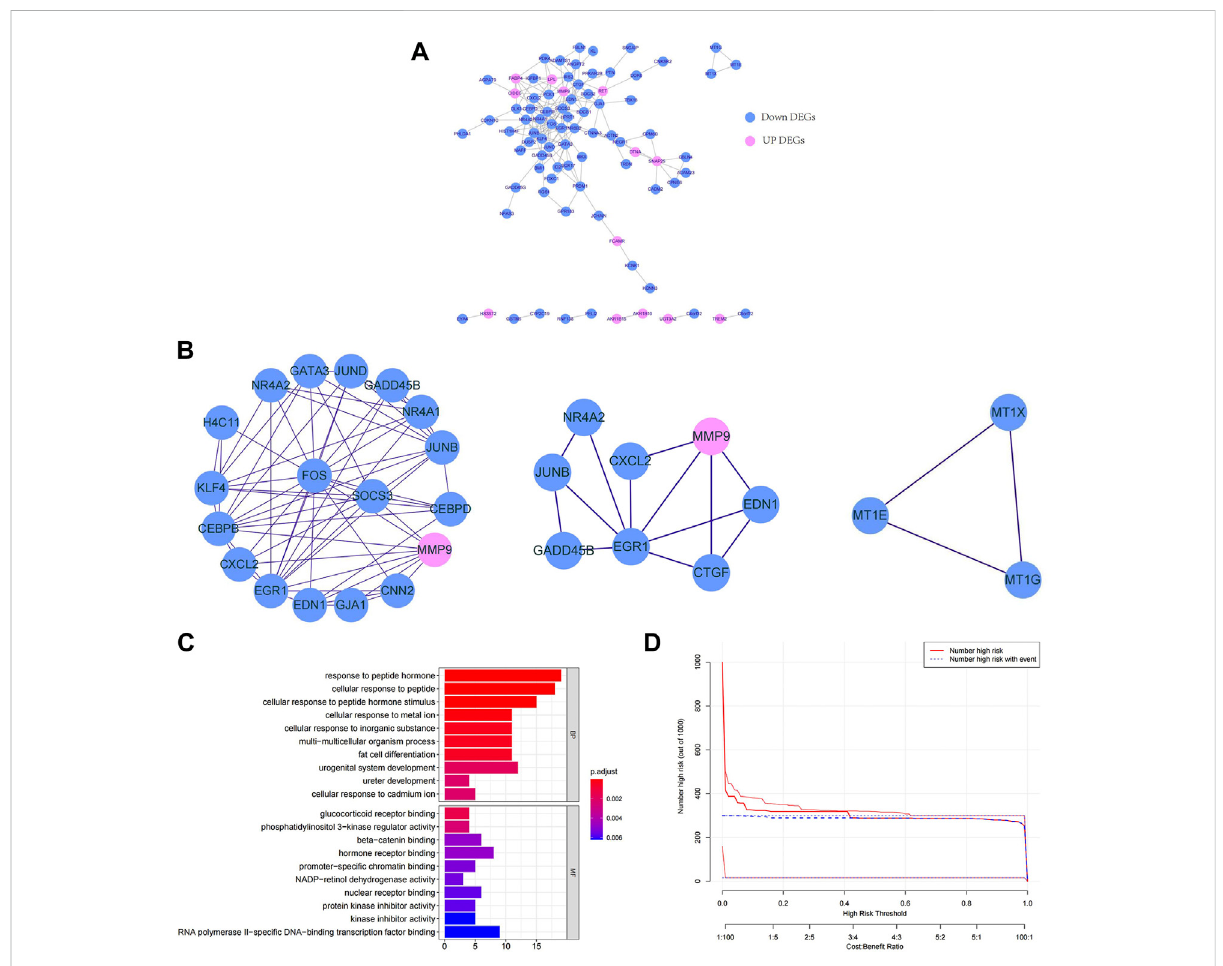
FIGURE 2 Functional enrichmentanalysis andinteractionofkeyDEGs. (A) PPInetwork ofkeyDEGs. (B) KeymodulesinthePPInetwork.Thelinesindicate the interaction between the DEGs. (C) GO enrichment bars for key DEGs. The ordinate indicates the enriched GO term, the length of the bars indicates the number of DEGs, and the colour from blue to red indicates the con fi dence from low to high. (D) Bubble chart of KEGG functional enrichment for key DEGs. The ordinate indicates the enrichmentKEGG pathway, the bubble size indicates thenumber of DEGs, and the colour from blue to red indicates the con fi dence from low to